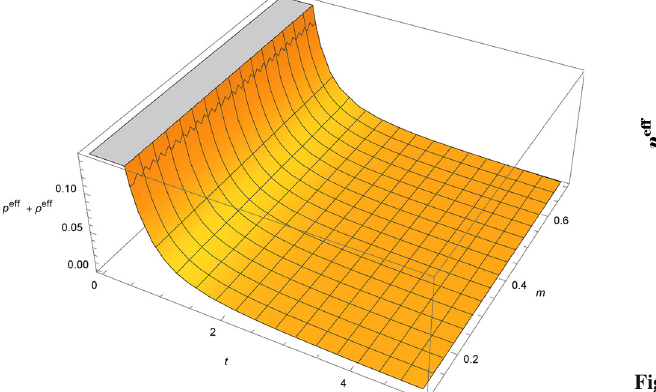
Fig. 7 Evolution of p eff in time